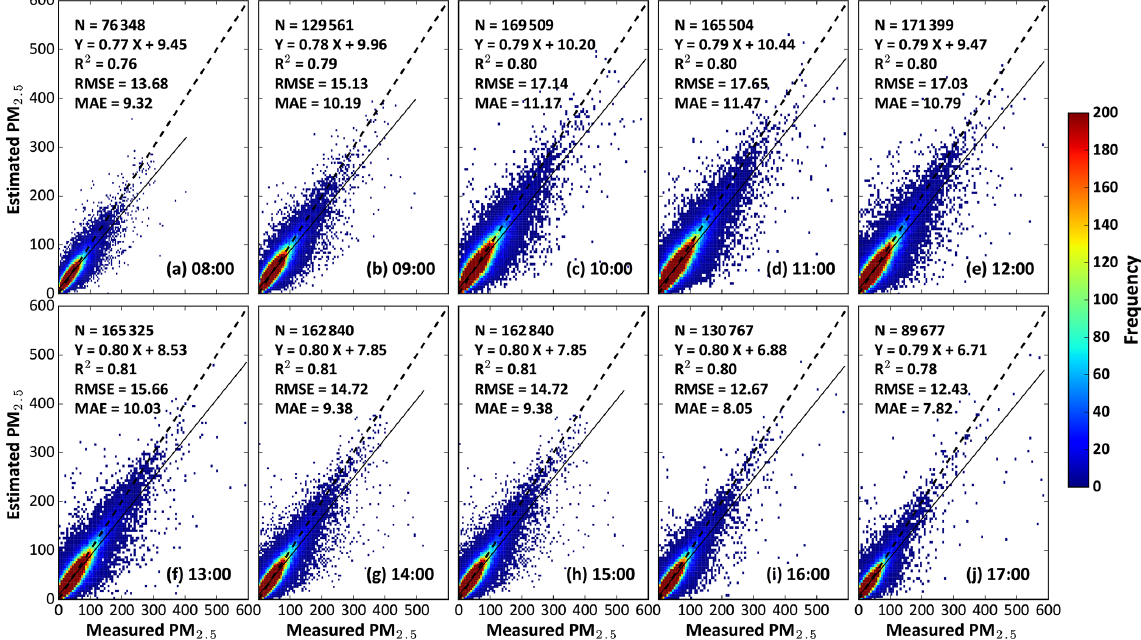
Figure 5. Density scatterplots of out-of-station cross-validation results of PM 2 . 5 estimates (µgm − 3 ) at (a) 08:00LT, (b) 09:00LT, (c) 10:00LT, (d) 11:00LT, (e) 12:00LT, (f) 13:00LT, (g) 14:00LT, (h) 15:00LT, (i) 16:00LT, and (j) 17:00LT in 2018 in China. Dashed and solid lines denote 1 : 1 and best-fit lines from linear regression, respectively.